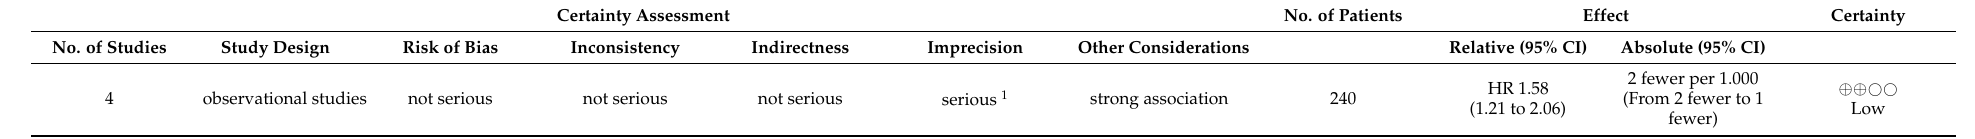
Table 4. Evaluation of GRADE